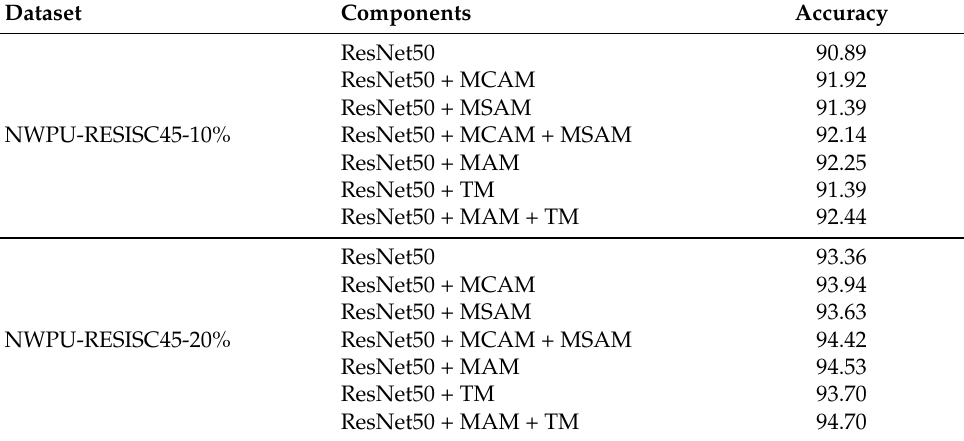
Table 5. Results (%) for our method with different components on the NWPU-RESISC45 dataset.